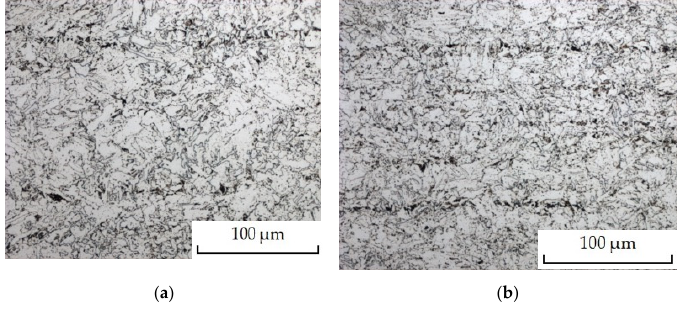
Figure 2. Metallographic structure of the tested steels: ( a ) 0 V; ( b ) 10 V. Table 4. Mechanical property of the tested